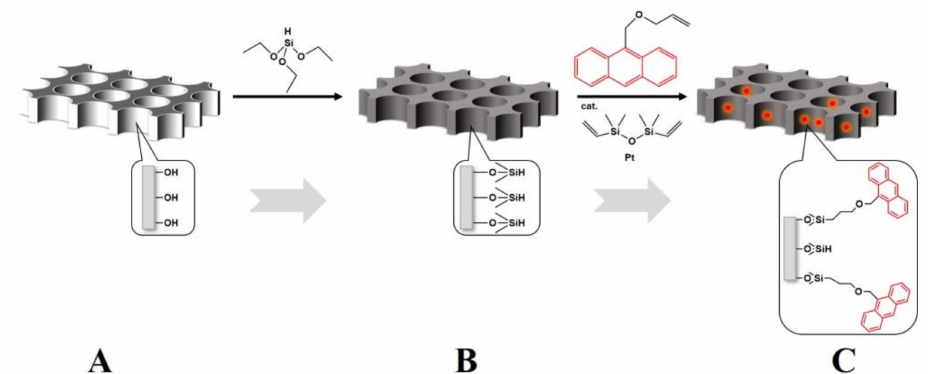
Figure 1. Labeling fluorophores on nanopore walls of AAO. ( A ) Hydrogen peroxide treatment results in a large amount of hydroxyl groups on the pore walls of AAO. ( B ) Hydroxyl groups coupled with triethoxysilane to prepare reactive hydrogen sites. ( C ) Anthryl-labeled pore walls. The red solid luminous dots represent the anthryl